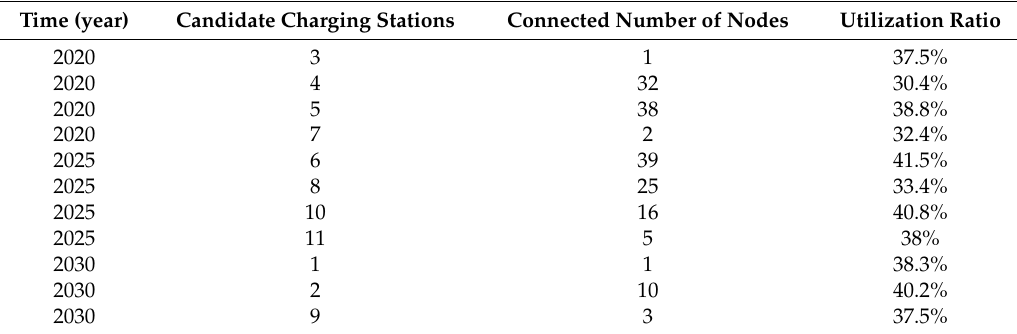
Table 13. Plan of the government for the charging